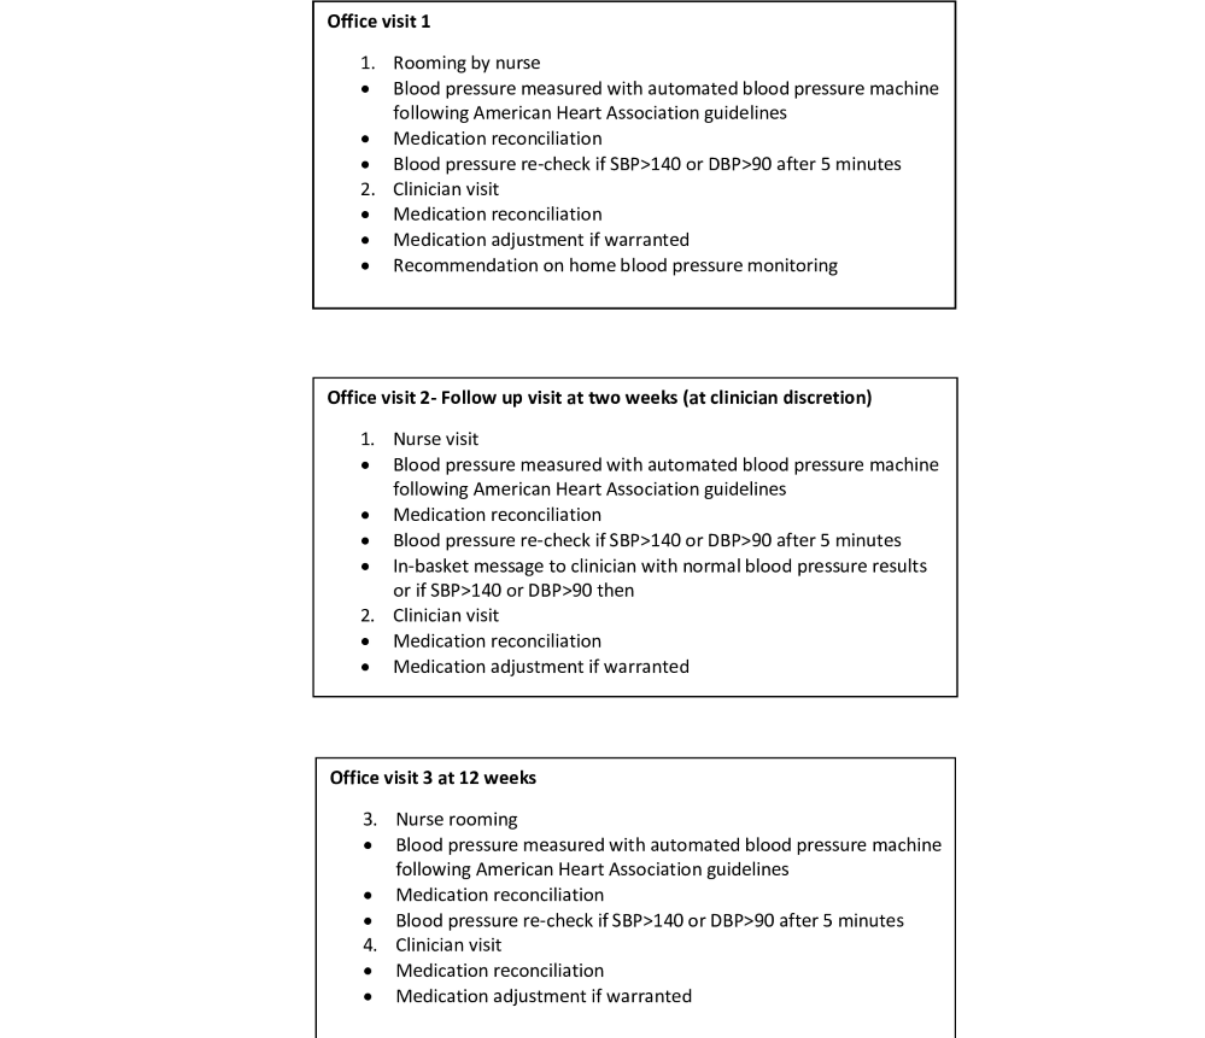
Figure 1. Usual care patient flow. DBP: diastolic blood pressure; SBP: systolic blood